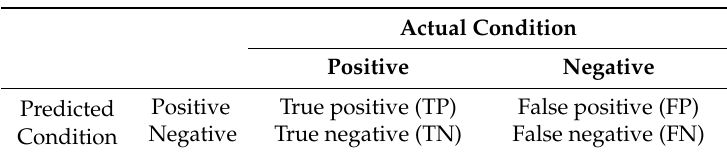
Table 1. Confusion Table 1. Confusion matrix.